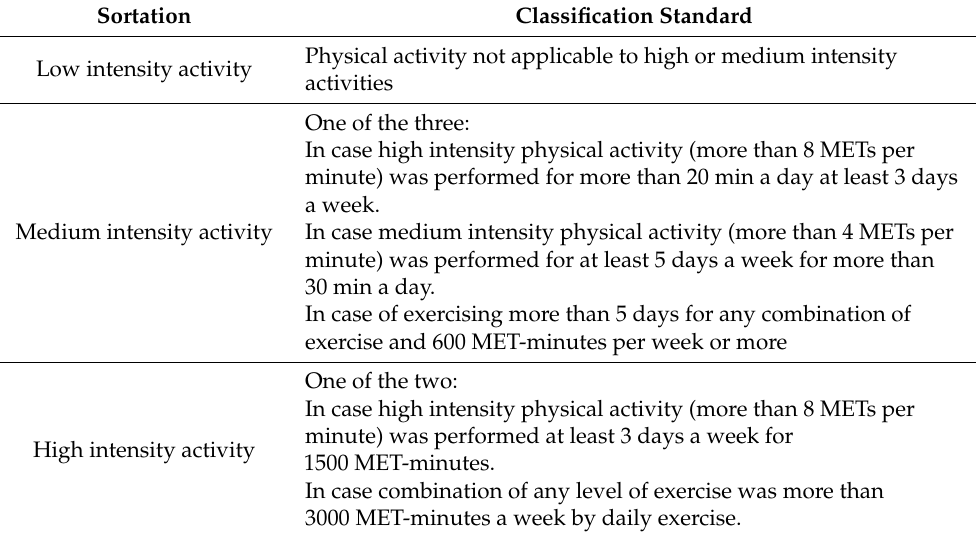
Table 3. Physical activity level classification criteria.